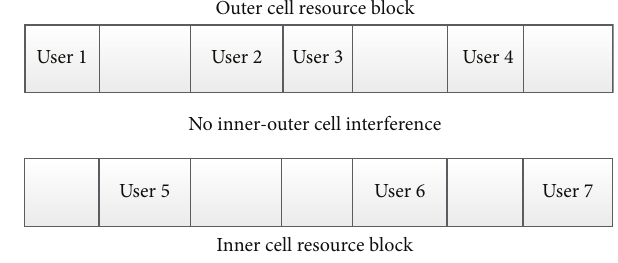
Figure 4: Previous scheduling scheme for vertical sectorization.